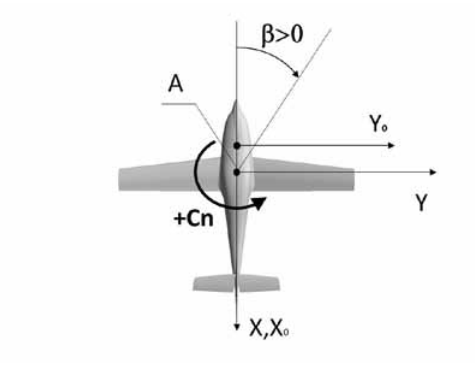
Fig. 4. Sign convention: yaw moment coefficient versus sideslip angle Fig. 5. Sign convention: rolling moment coefficient